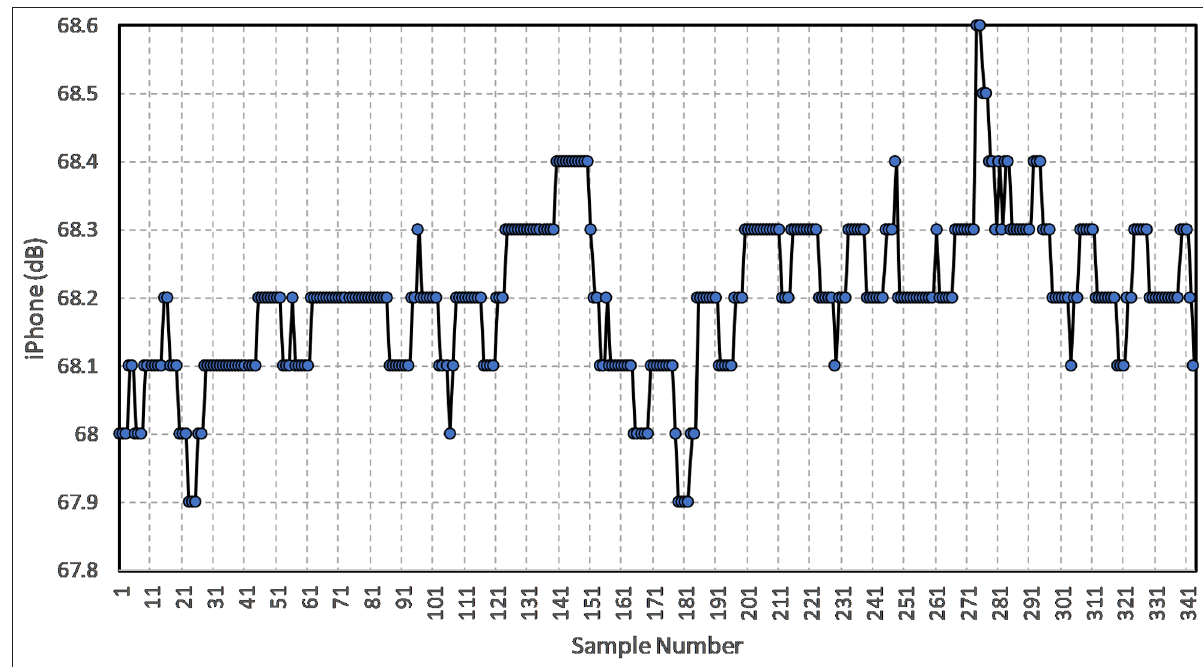
Figure 5: Representative fixed sound intensity data for the iPhone 6s with samples every 0.2 seconds. <S> = 68.2 ± 0.11 dB. Table 3: Sound comparisons with Samsung